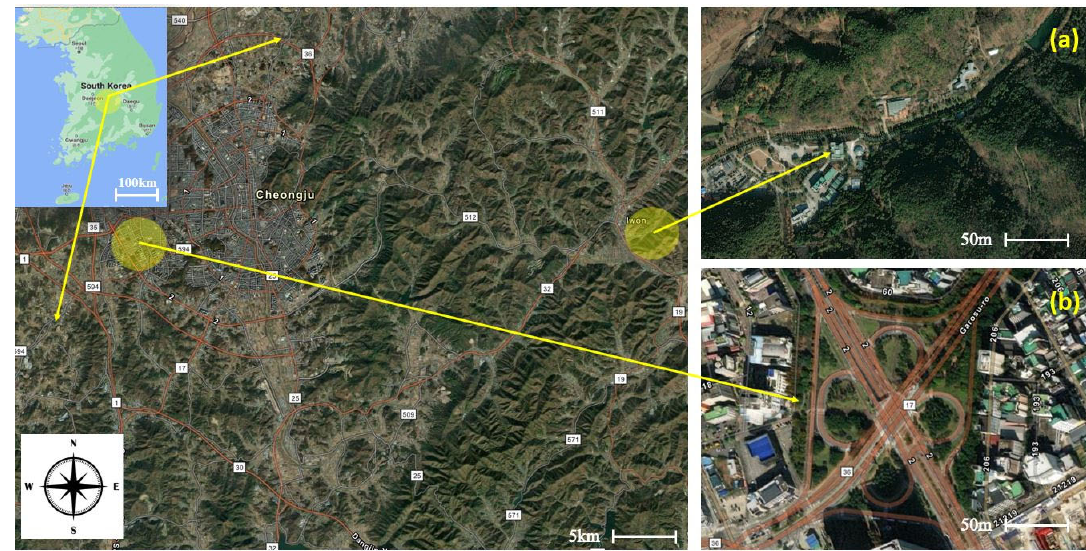
Figure 1. The location map of the two sampling sites. ( a ) Urban forest (Chungcheongbuk-do Forest Environment Research Institute) and ( b ) Roadside (Crossroad near Chenogju Express Bus Terminal).